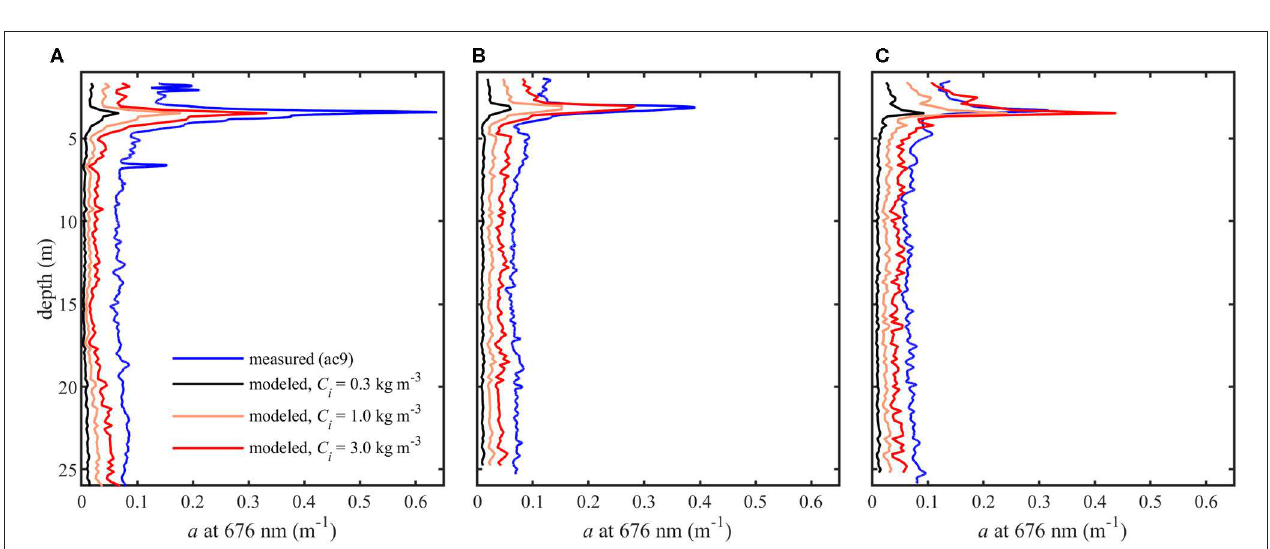
FIGURE 7 | Modeled phytoplankton absorption coefficients ( a ph ) at 0.3, 1.0, and 3.0 kg m − 3 intracellular chlorophyll concentrations ( C i ) and measured total absorption coefficients ( a pg ) at 676 nm for three profiles (A–C)